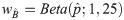
Power comparison for FamBAC, FamKAC, and RVFam for effects of causal rare variants in mixed directions.Simulations were based on 1, 000 replicates with causal rare variants having effects in mixed directions (+/-: 0/100, 20/80, and 50/50) on age-at-onset (AAO) for different Vg: (A) Vg = 5; (B) Vg = 10; (C) Vg+ = 10 for causal rare variants with positive effects and Vg− = 5 for causal rare variants with negative effects; and (D) Vg+ = 5 for causal rare variants with positive effects and Vg− = 10 for causal rare variants with negative effects. The other parameters were fixed at 30% censoring rate, 2, 000 trios, and 30% causal rare variants. Method notations are as the following: FamBAC: FamBAC with no variant weight w0 = 1; FamBACB: FamBAC with variant weight wB^=Beta(p^;1,25) where p^ is the sample minor allele frequency (MAF) estimated from the between-family component Gb; FamKAC: FamKAC with w0; FamKACB: FamKAC with variant weight wB^; and RVFamB: RVFam with variant weight wB^.